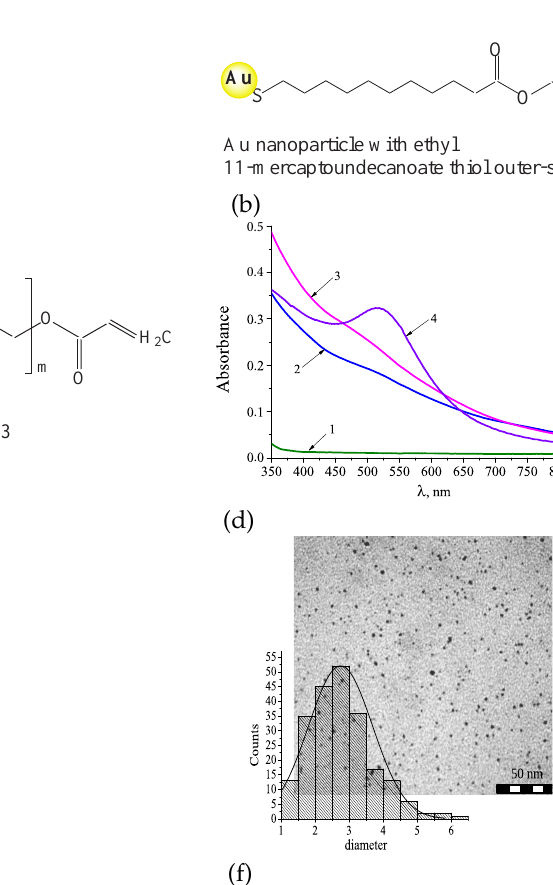
Figure 3. The structures of the monomers used in the nanocomposites and their refractive indices ( a – c ). Optical spectra of the layers ( d ): Without Au nanoparticles (NPs) (curve 1), and with different concentrations of Au NPs : 1.5 wt. % Au1 (curve 2); 2 wt. % Au1 (curve 3); 1.3 wt. % Au2 (curve 4); TEM image and histogram of the size distribution of Au1 NPs (area is 0.17 µ m × 0.17 µ m; average diameter is 1.7 nm; standard deviation is 0.36 nm) ( e ) and Au2 NPs (area is 0.19 µ m × 0.17 µ m; average diameter is 2.7 nm; standard deviation is 0.94 nm) ( f